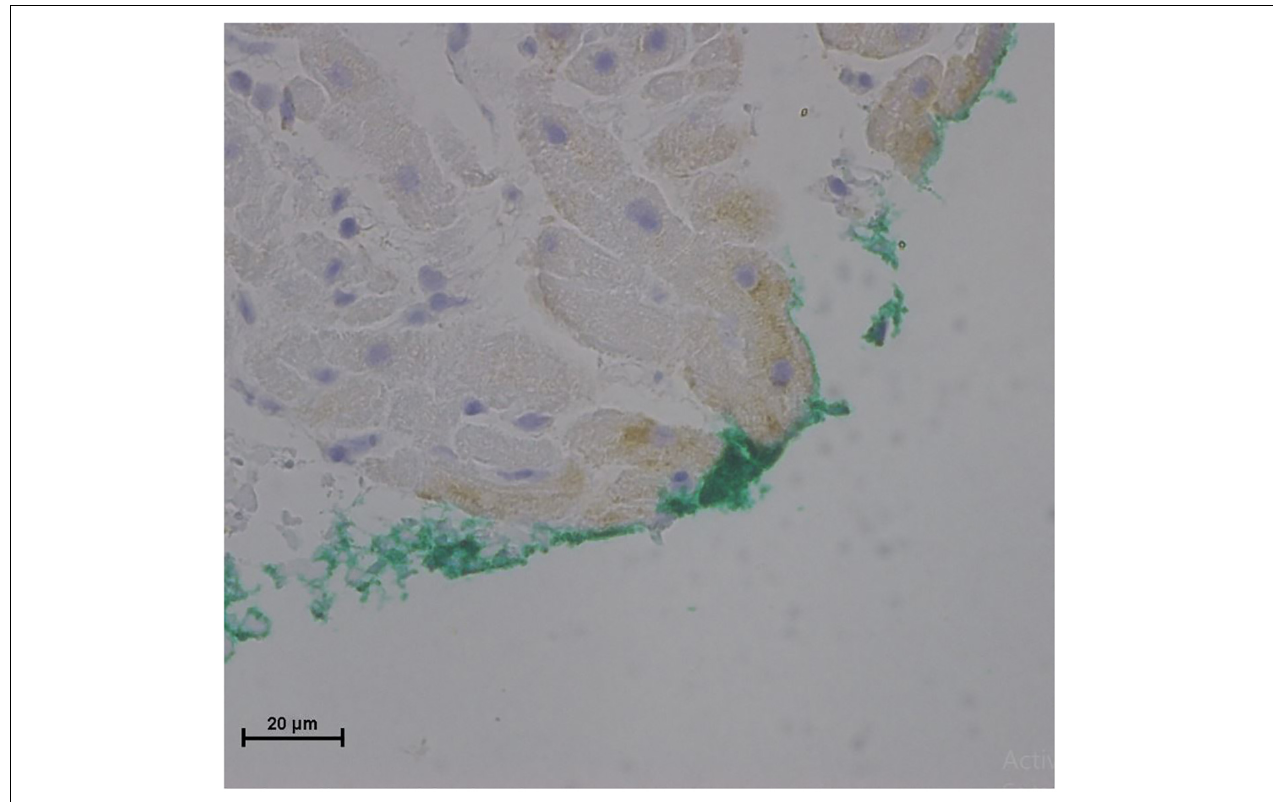
FIGURE 6 | Light microscopy view of the luminal aspect of the superior vena cava away from the AHS. Green line denotes the luminal aspect. There are intact endothelial cells.